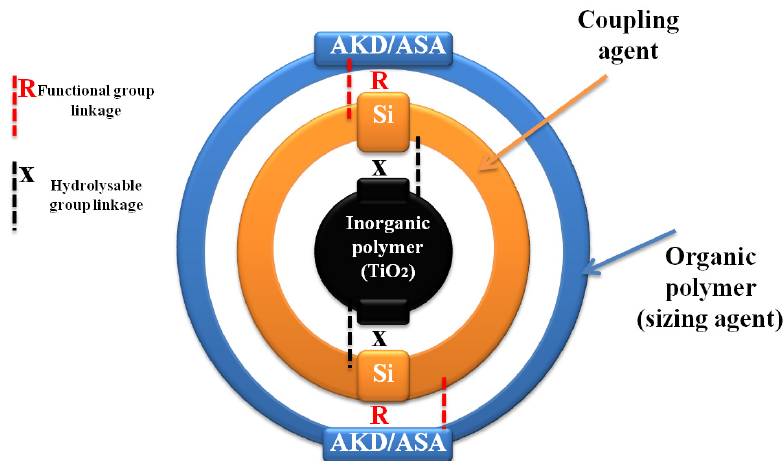
Figure 2. Silane interface bonding, redrawn from [51].